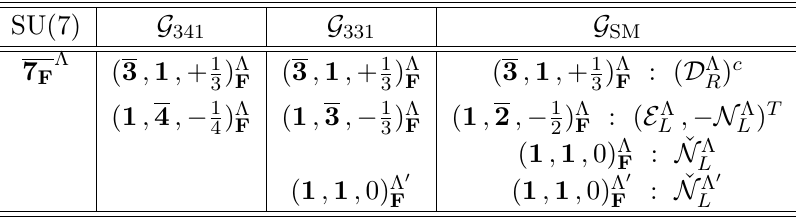
Table 2 . The SU(7) fermion representation of 7 F Λ under the G 341 , G 331 , G SM subgroups for the SU(7) model, with Λ = ( λ , ˙ λ ) , λ = (I , II , 3) , and ˙ λ = (˙I , ˙2) . Here, we denote ( D Λ the SM right-handed down-type quarks, and ( D Λ